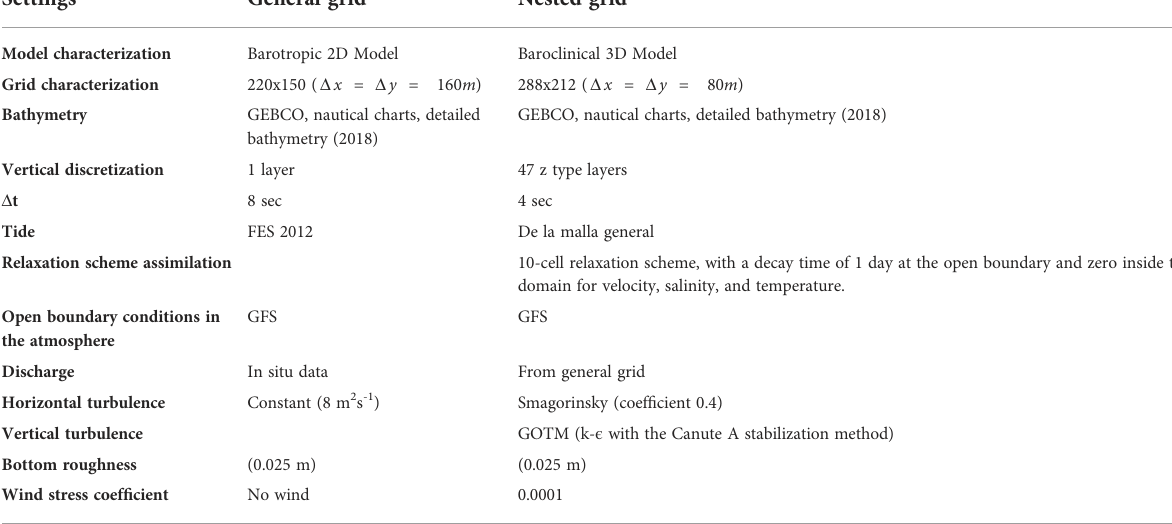
TABLE 1 MOHID Model con fi